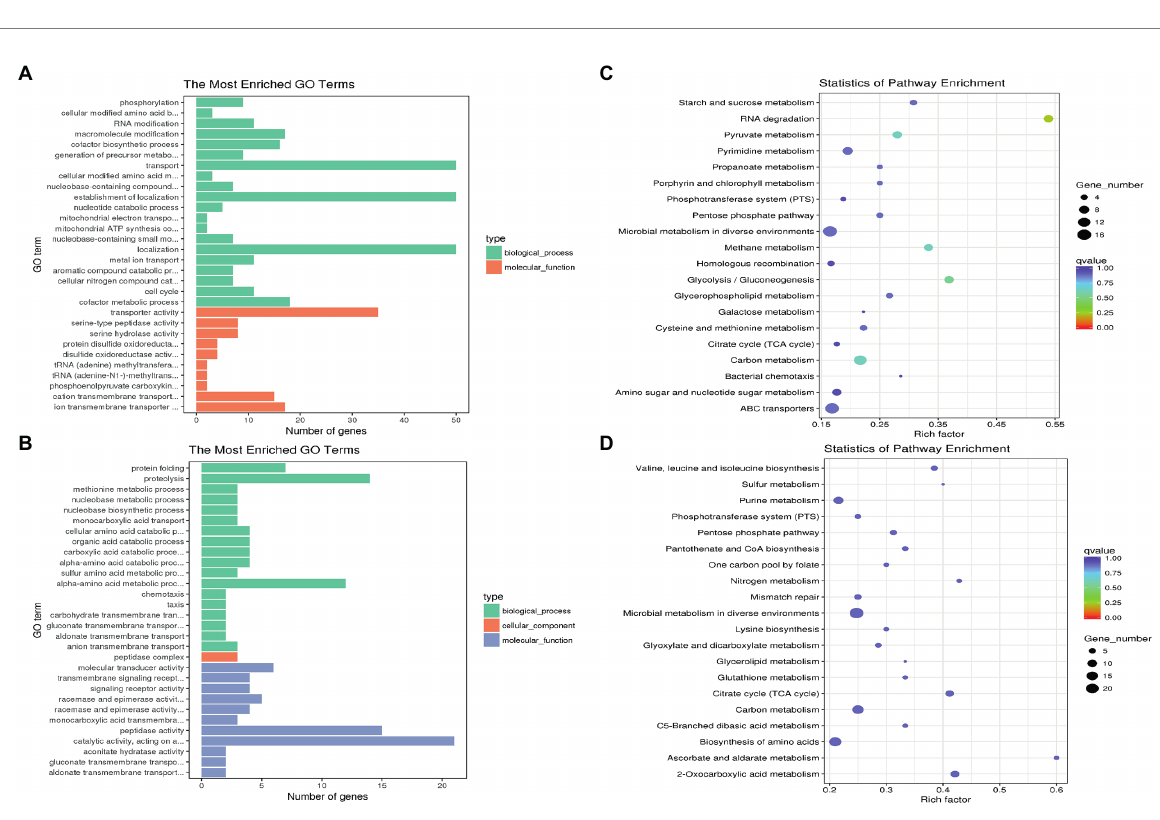
According to the KEGG analysis, 444 differentially expressed genes between GPS2 and Δ luxS groups were annotated to be involved in 65 different pathways. Compared with GPS2, the